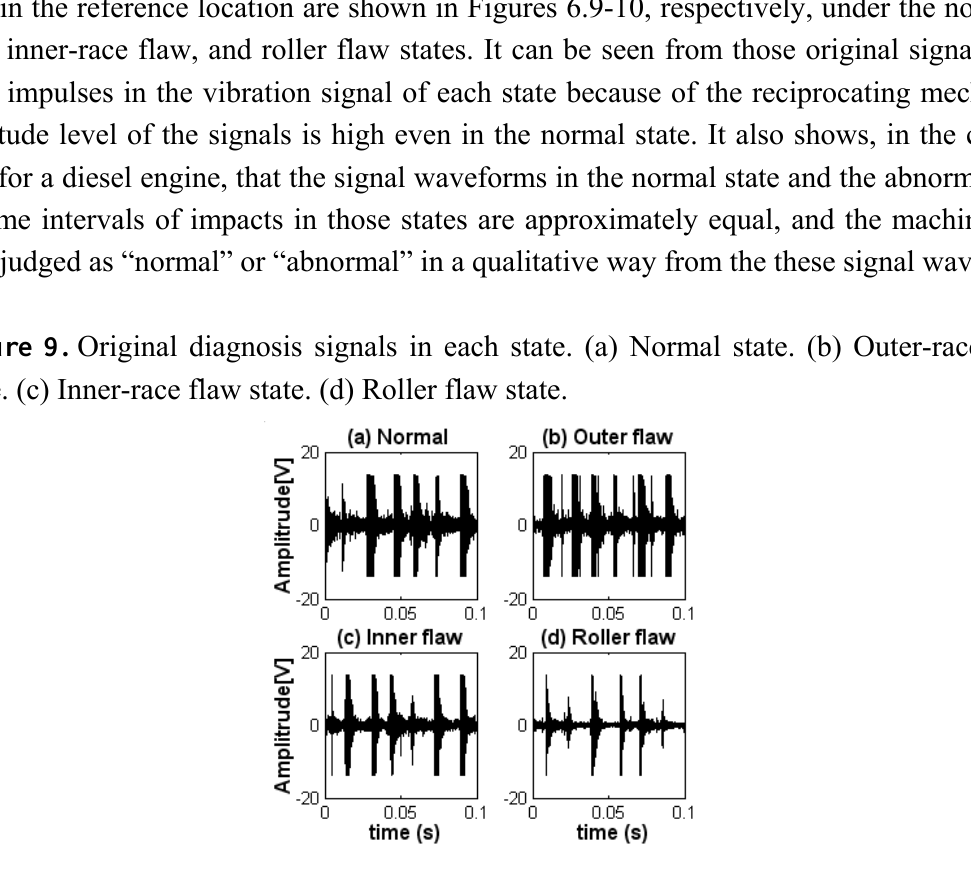
Figure 10. Original reference signals in each state. (a) Normal state. (b) Outer-race flaw state. (c) Inner-race flaw state. (d) Roller flaw